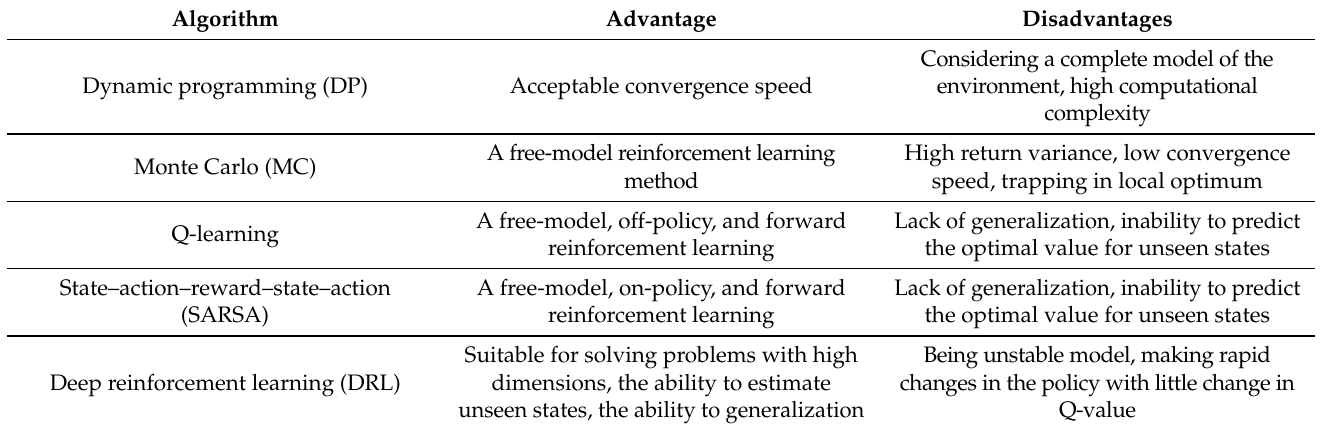
Table 1. Comparision of reinforcement learning algorithms